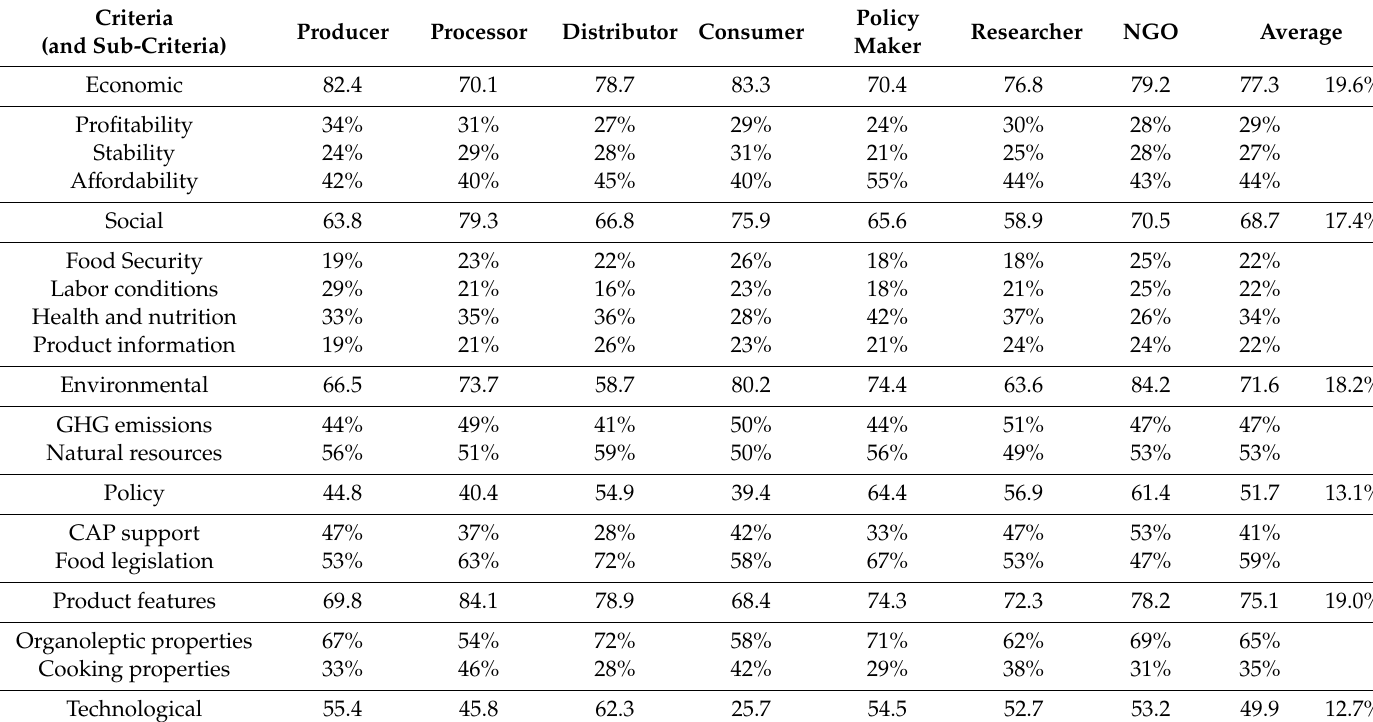
Table A1. Mean criteria and sub-criteria weights for each stakeholder group. Criteria weights are express in absolute values and in percentage terms. Sub-criteria values are expressed in percentage of absolute criteria